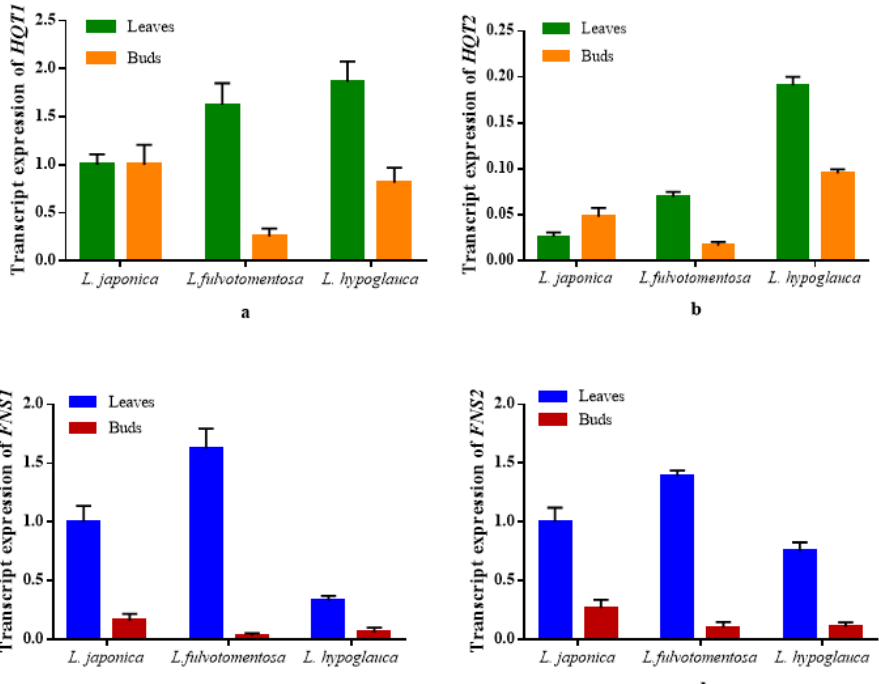
Fig. 4: The transcript expression levels of HQT1 (a), HQT2 (b), FNS1 (c) , and FNS2 (d) in two different parts of the flower buds and leaves of the three species at the golden flowering stage and silver flowering stage were detected by q-RT